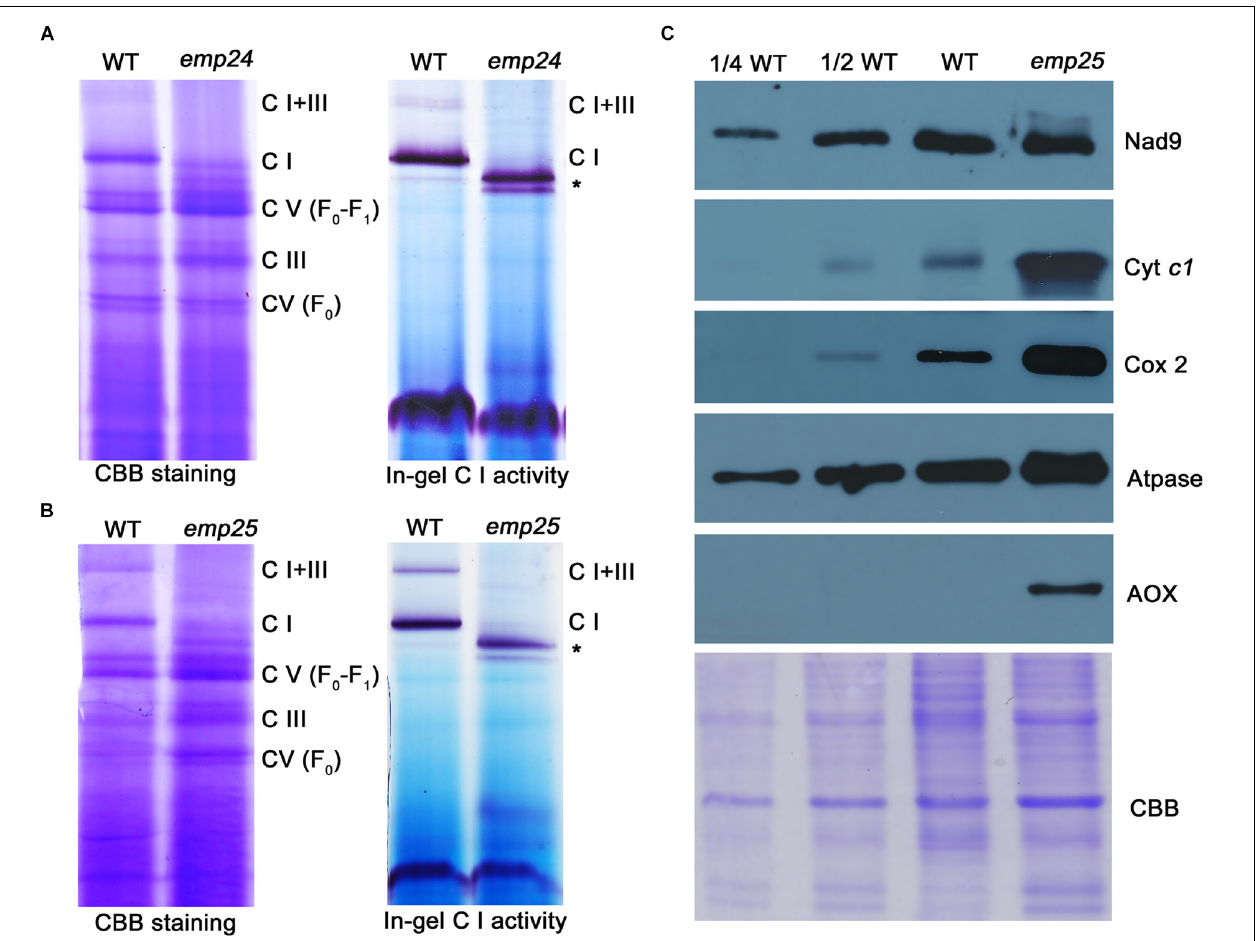
FIGURE 7 | Defect in the complex assembly and activity in emp24 and emp25. (A,B) The blue native polyacrylamide gel electropheresis (BN-PAGE) gel was stained with Coomasssie Brilliant Blue (CBB). In-gel NADH dehydrogenase activity assay of complex I used dihydrolipoamide dehydrogenase (DLDH) as a loading control. C I: Complex I; C III: Complex III; C V: Complex V; *: sub-complex I detected in mutant. (C) Crude mitochondrial extracts from endosperm and embryo of emp25 with sibling WT kernels were used for Western blot analysis with antibodies against Nad9, Cyt c1 , Atpase, Cox2, and AOX. CBB staining was used as a loading